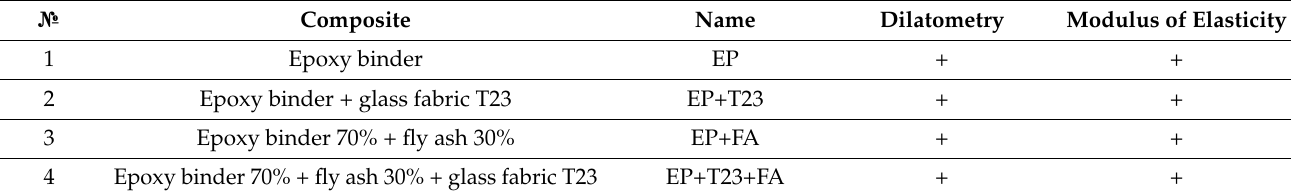
Table 1. Types of composites and FRPs